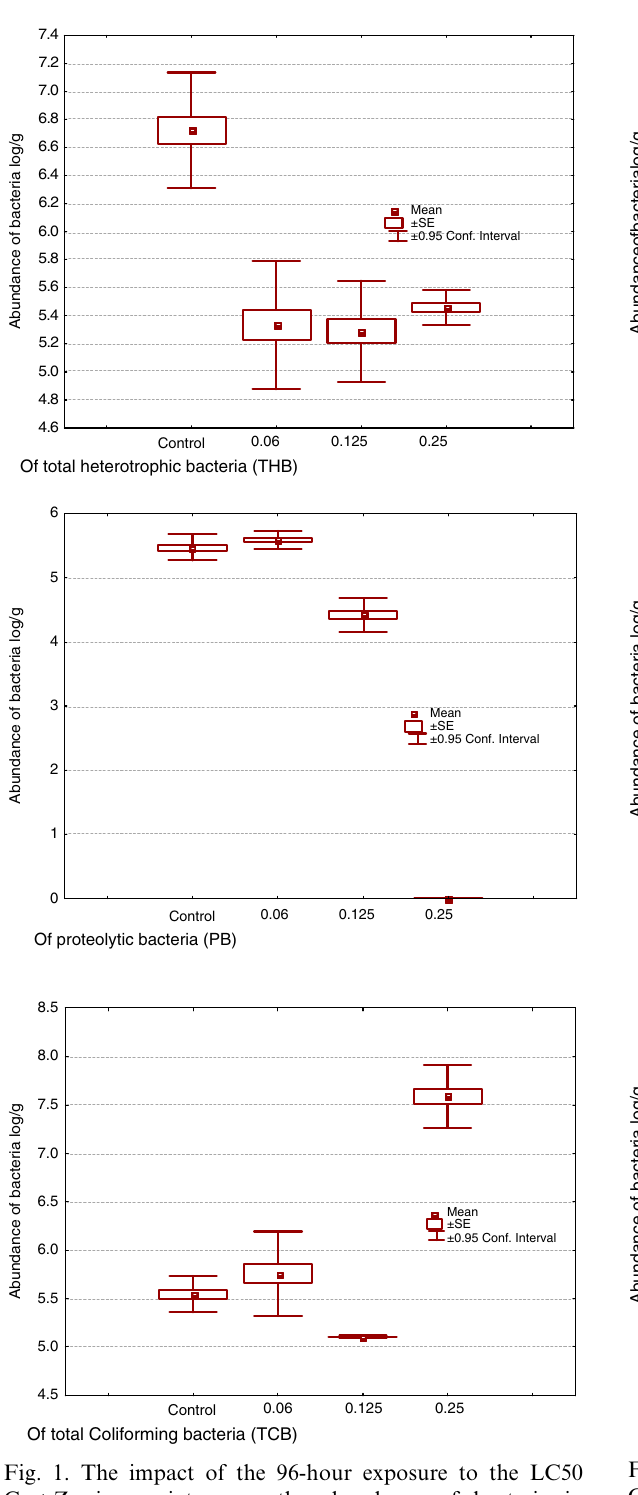
Fig. 1. The impact of the 96-hour exposure to the LC50 Cu (cid:2) Zn ions mixture on the abundance of bacteria in digestive tract of rainbow trout (Oncorhynchus mykiss) Concentration in portion of equitoxic 96-hour LC50 mixture